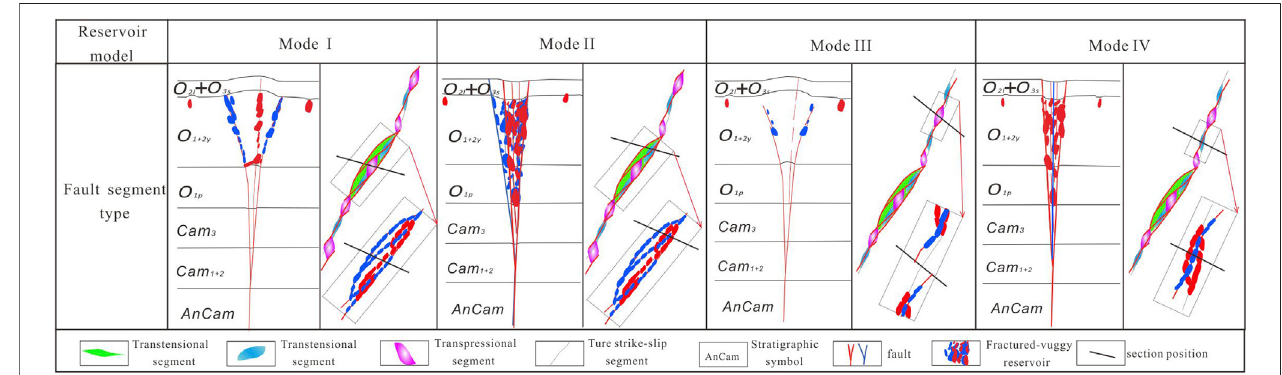
FIGURE 9 | TP12CX fault segmentation type and reservoir